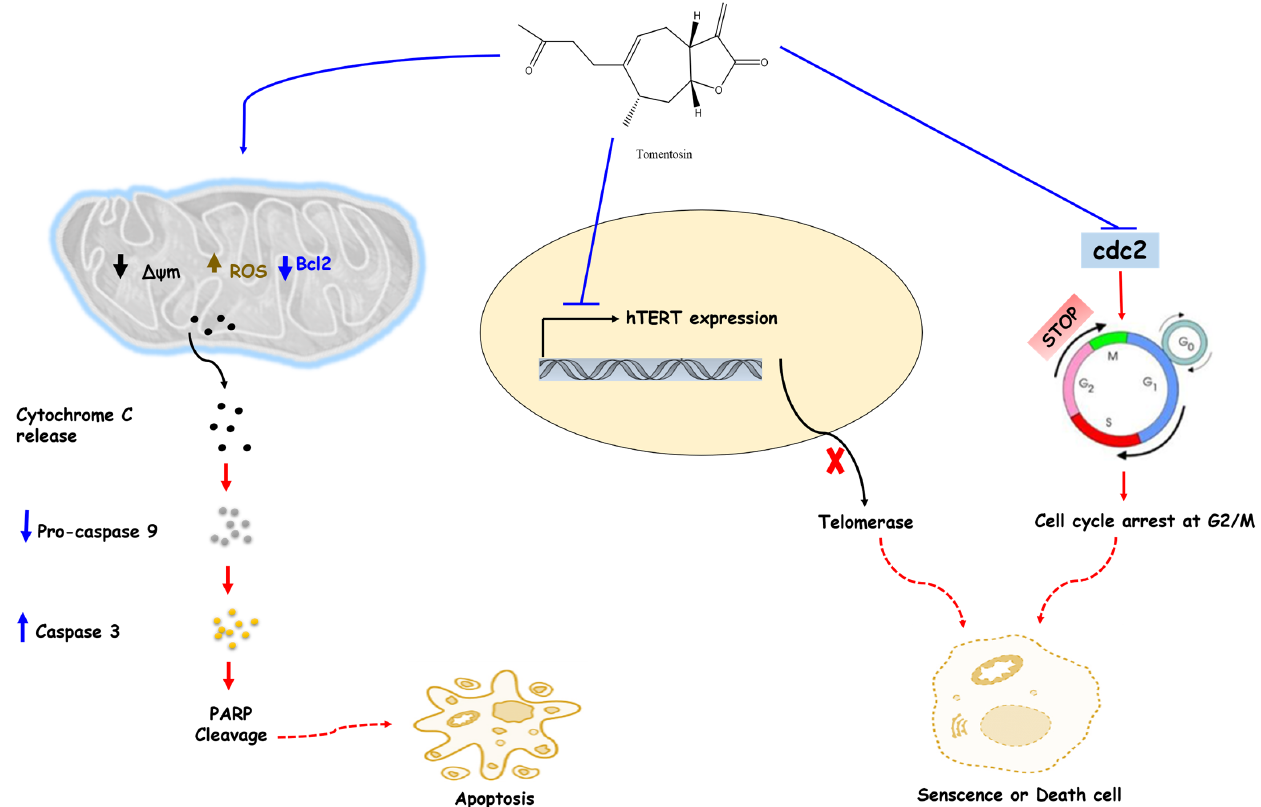
Figure 2. Anticancer mechanisms of Tomentosin.